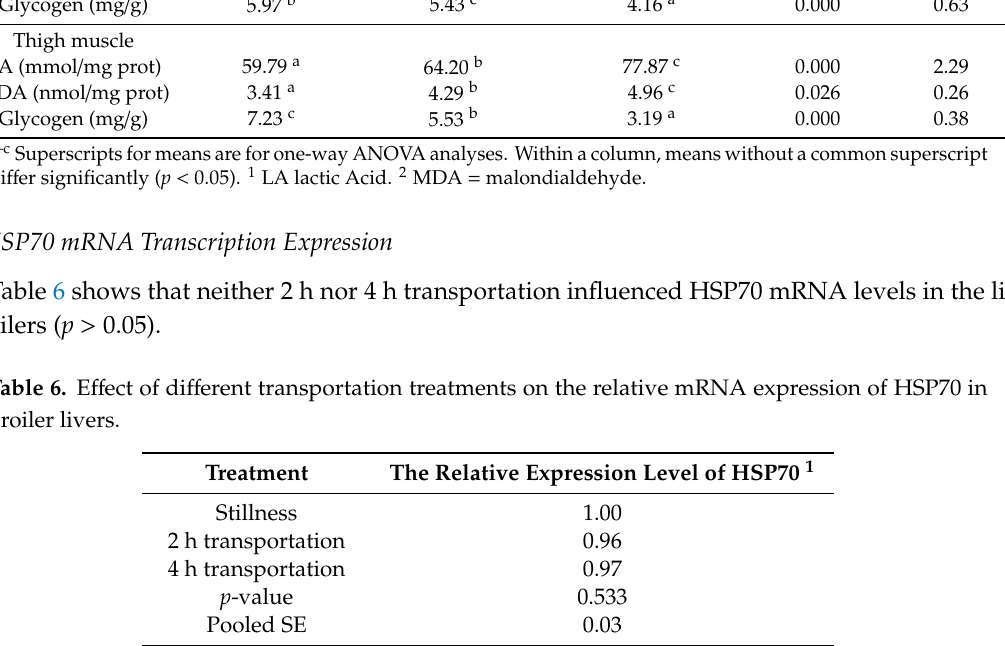
Table 5. E ff ect of di ff erent transportation treatments on metabolites in broiler muscle. Treatment Item Stillness